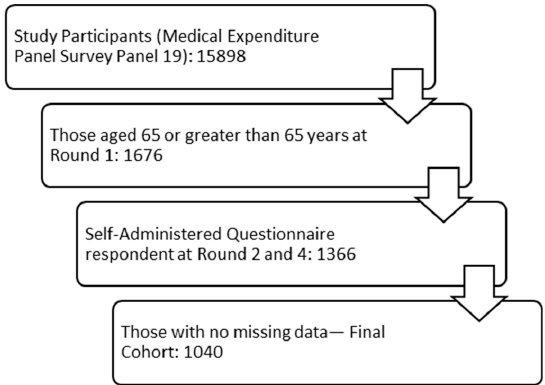
Figure 1. Figure depicting the sample selection process.